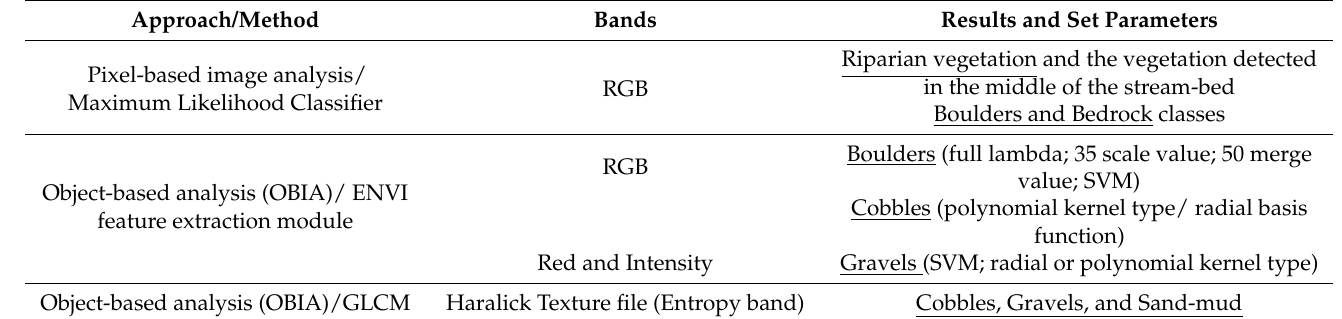
Table 5. Pixel- and object-based image analysis methods that indicated better classification